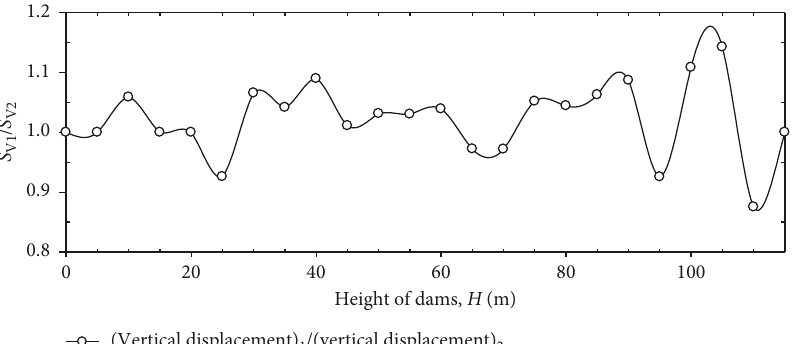
Figure 3: Ratio of the vertical displacement of the first sample to the vertical displacement of the second